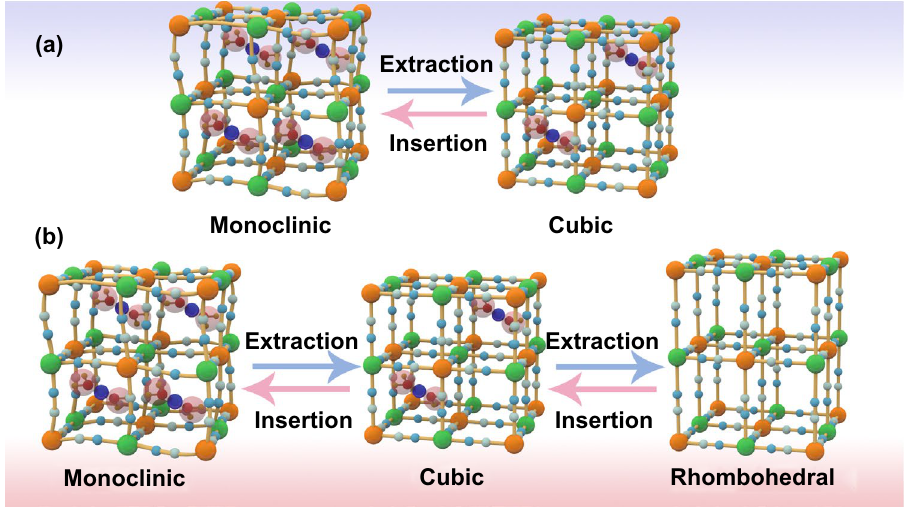
Fig. 5 Structure transformation of PBAs a between monoclinic and cubic structures and b among monoclinic, cubic and rhombohedral struc-